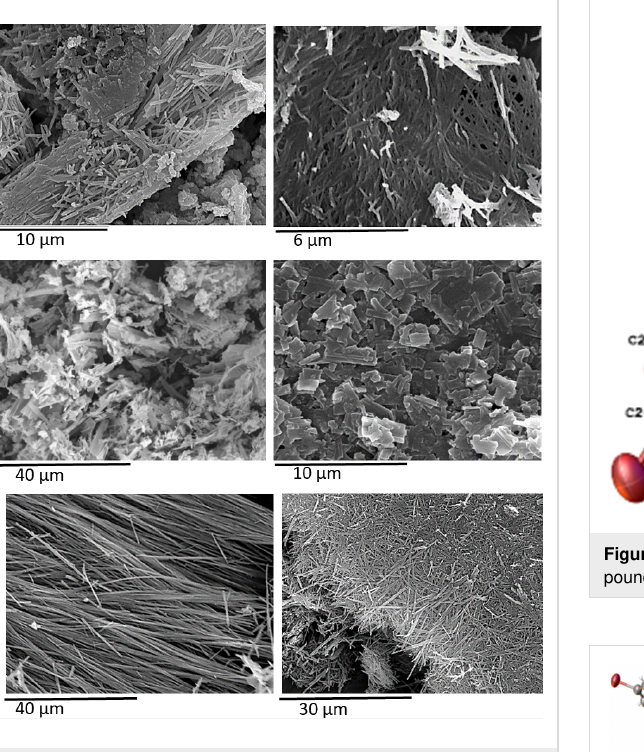
Figure 2: SEM images of the xerogels of compounds 7f (DMSO, top left), 8f (DMSO/H 2 O, 3:1, v/v, top right), 10 (DMSO/H 2 O, 1:1, v/v, mid- dle left), 10 (DMSO/H 2 O, 1:2, v/v, middle right), 12 (DMSO, bottom left), and 14 (DMSO/H 2 O, 9:1, v/v, bottom right).